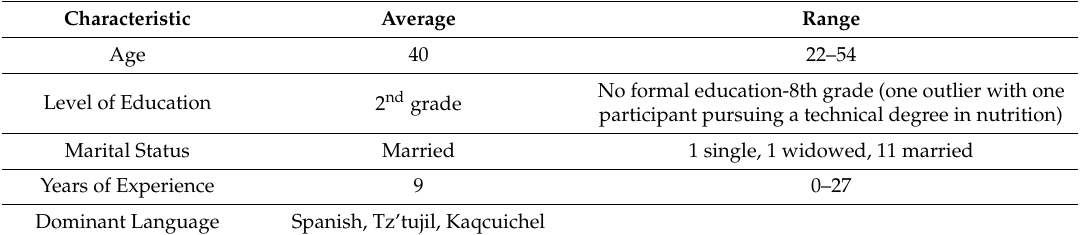
Table 1. Traditional birth attendant participant